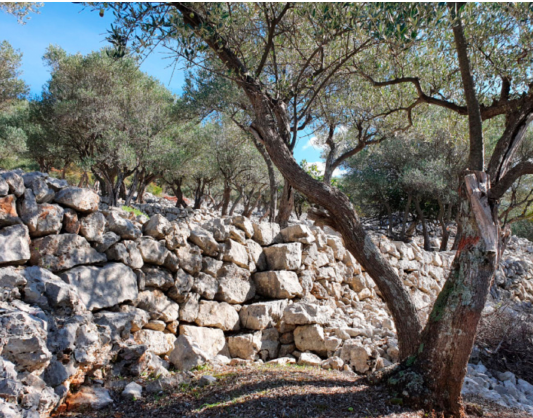
Figure 29. Dry stone wall details: stairs as main avenues of approach to the olive grove and within terraces (Tanja Kremeni´c, 2020).